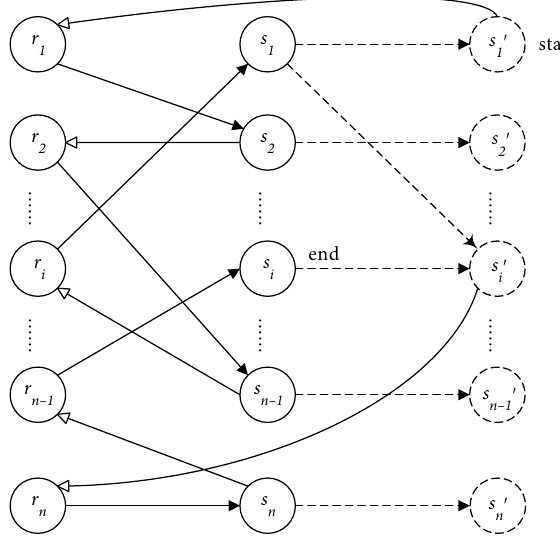
Figure 4: The operation path of gantry crane.